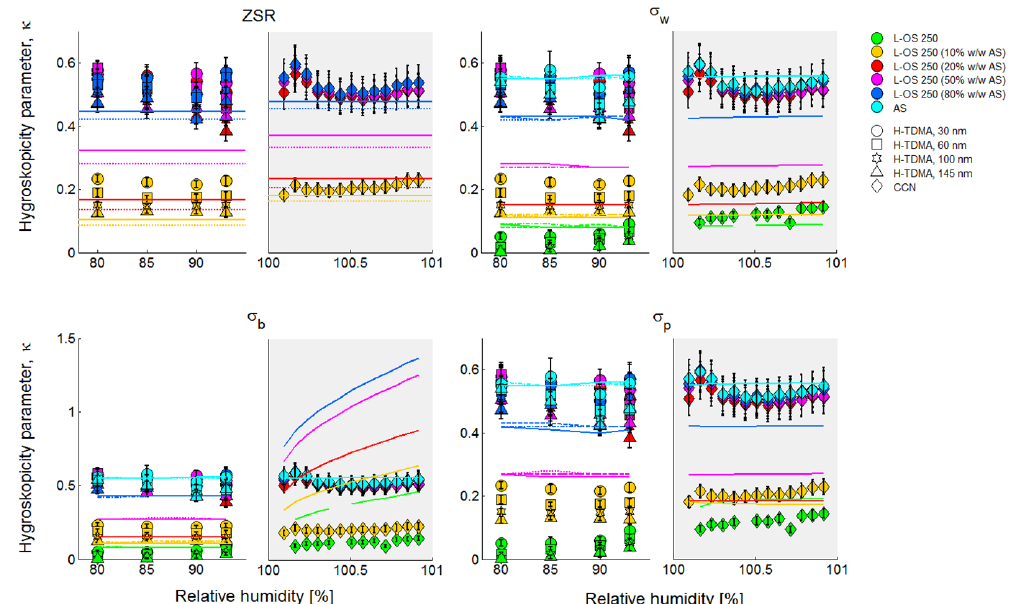
Figure 9. Measured and modelled hygroscopicity parameter, κ , as a function of RH for six mixtures of L-OS 250 and AS. Markers represent the measured values of κ and lines represent the modelled values of κ . The light grey area denotes humidity in the supersaturated range (CCN) and the white area denotes humidity in the subsaturated range (H-TDMA). For subfigure ZSR the solid lines represent additive κ calculated using a density of 1.176gcm − 3 for L-OS 250 whereas a density of 1.7gcm − 3 is represented with the dotted lines. For subfigure σ w , σ b and σ p , the subsaturated range, the solid line is modelled κ for 30nm particles, the dash-dotted line is modelled κ for 60nm particles, the dotted line is modelled κ for 100nm particles and the dashed line is modelled κ for 145nm particles. Error bars represent the uncertainty on the κ values obtained from the measurements ( ± 10% on κ CCN and ± 2 standard deviation on κ H-TDMA ) . Please note that the y axis in subfigure σ b is different form the other